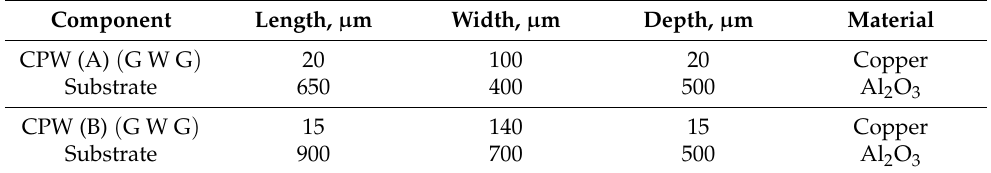
Table 5. Specification of CPW (A) and CPW